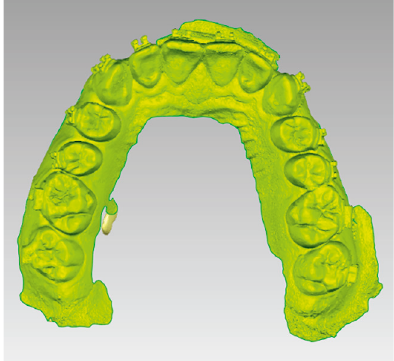
Figure 7: Postoperative model STL file.